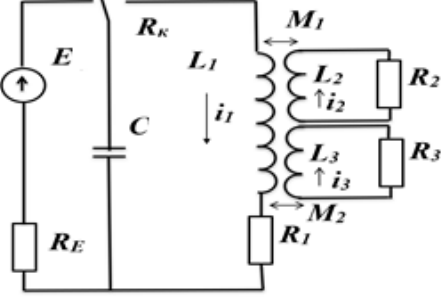
Figure 2. Auxiliary circuit of electric pulse heater with capacitive storage [own elaboration]: L 1 —inductance of the coil, L 2 —inductance of the inner ferromagnetic core, L 3 —inductance of the outer ferromagnetic shield, M 1 —mutual inductance between the coil and the inner ferromagnetic core), M 2 —mutual inductance between the coil and the outer ferromagnetic shield, R 1 , R 2 , R 3 , R k are, respectively, the values of the resistances of the coil, the inner ferromagnetic core, the outer ferromagnetic screen and the key.